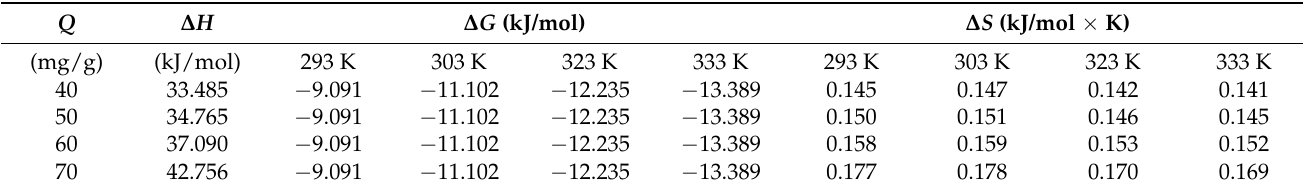
Table 8. Thermodynamic properties of the methyl orange adsorption onto